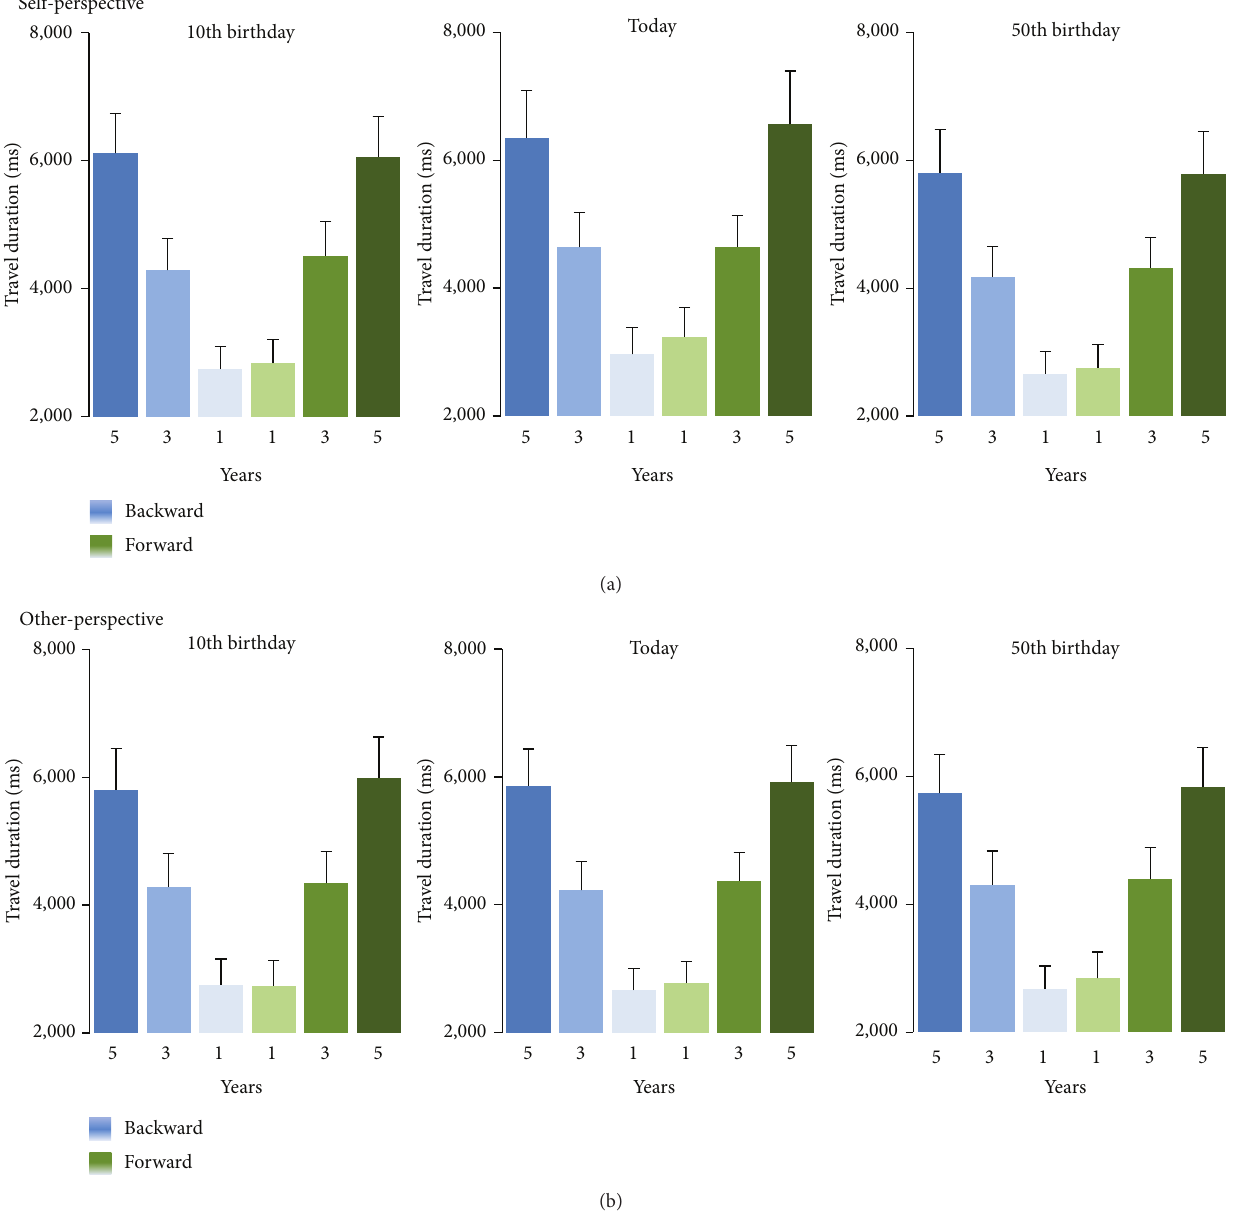
Figure 2: Durations (ms) for time travelling one, three, or five years backwards (blue tone bars) or forwards (green tone bars) from the past (10th birthday), the present (i.e., today), or the future (i.e., 50th birthday) in self-perspective (a) and other-perspective (b). Error bars depict standard error of